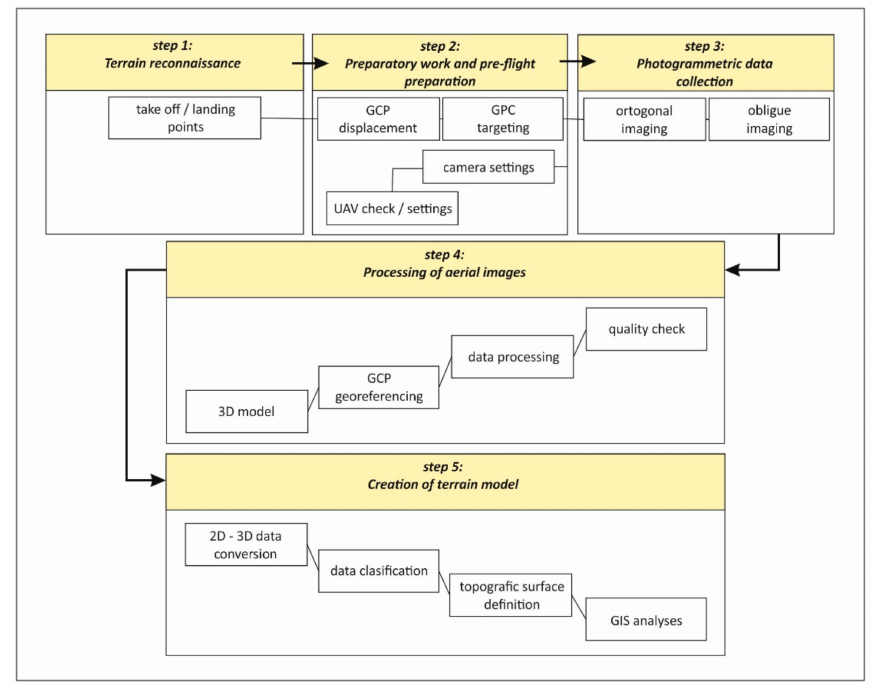
Figure 4. Example of data collection methodology using unmanned aerial system (UAS) for modeling georelief, according to